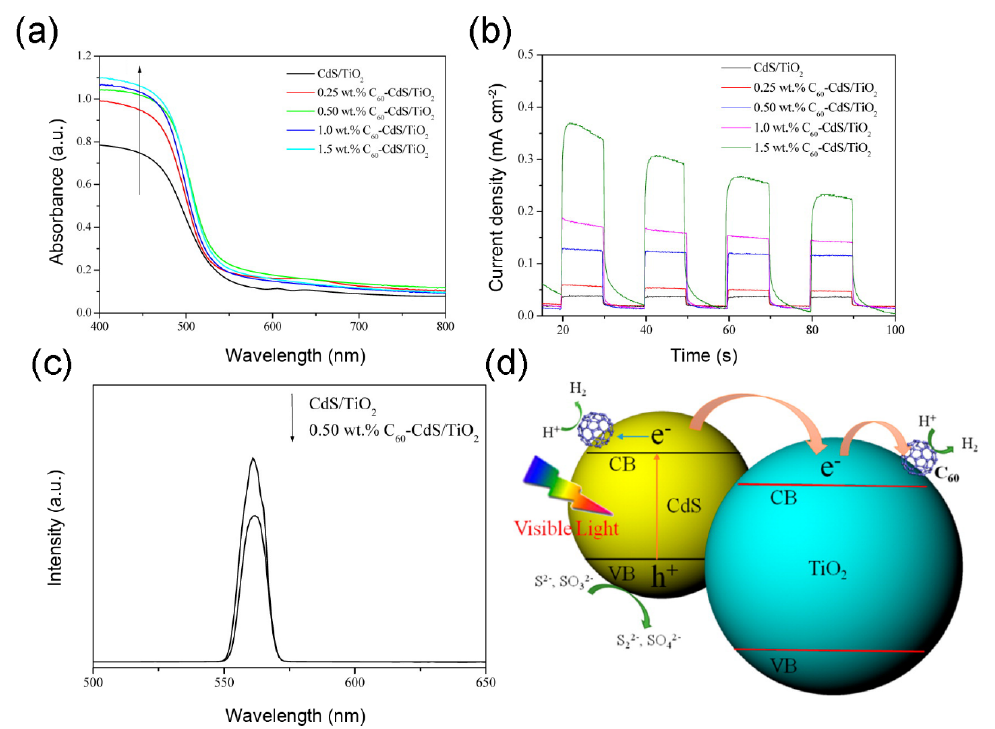
Figure 4. UV-vis spectra ( a ), photocurrent density measured at 0.5 V in a 0.5 M aqueous Na 2 SO 4 electrolyte ( b ) and PL spectra ( c ) excited by 280 nm of CdS / TiO 2 and C 60 -CdS / TiO 2 nanocomposites. ( d ) The mechanism of photocatalytic H 2 generation over C 60 -CdS / TiO 2 . Reproduced with permission from Reference [84]. Copyright 2015, ACS.